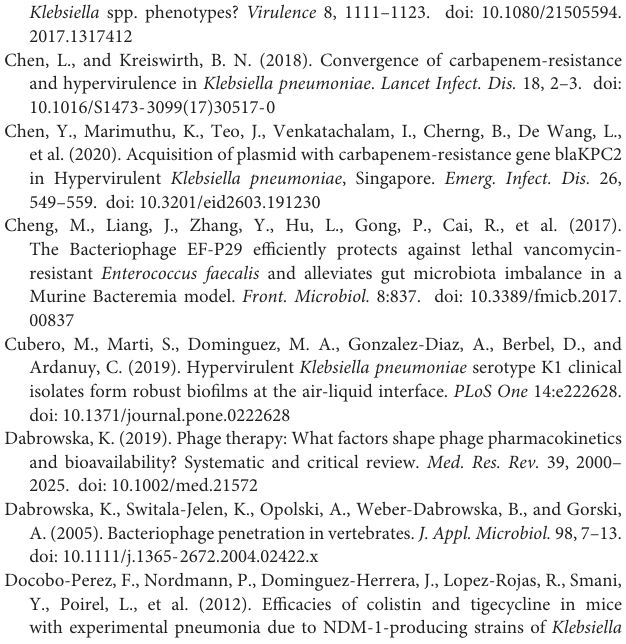
Supplementary Figure 1 | Box plot of the alpha diversity indexes (Chao1, ACE, Shannon, and Simpson). Supplementary Figure 2 | Principal coordinates analysis (PCoA) plot based on Bray-Curtis (A) and weighted UniFrac distances (B) . Each point represents the microbial community structure of an individual fecal sample. Supplementary Figure 3 | Relative abundance of species at different classification levels (phylum, class, order, family, genus). The abscissa shows grouping information, and the ordinate shows the relative